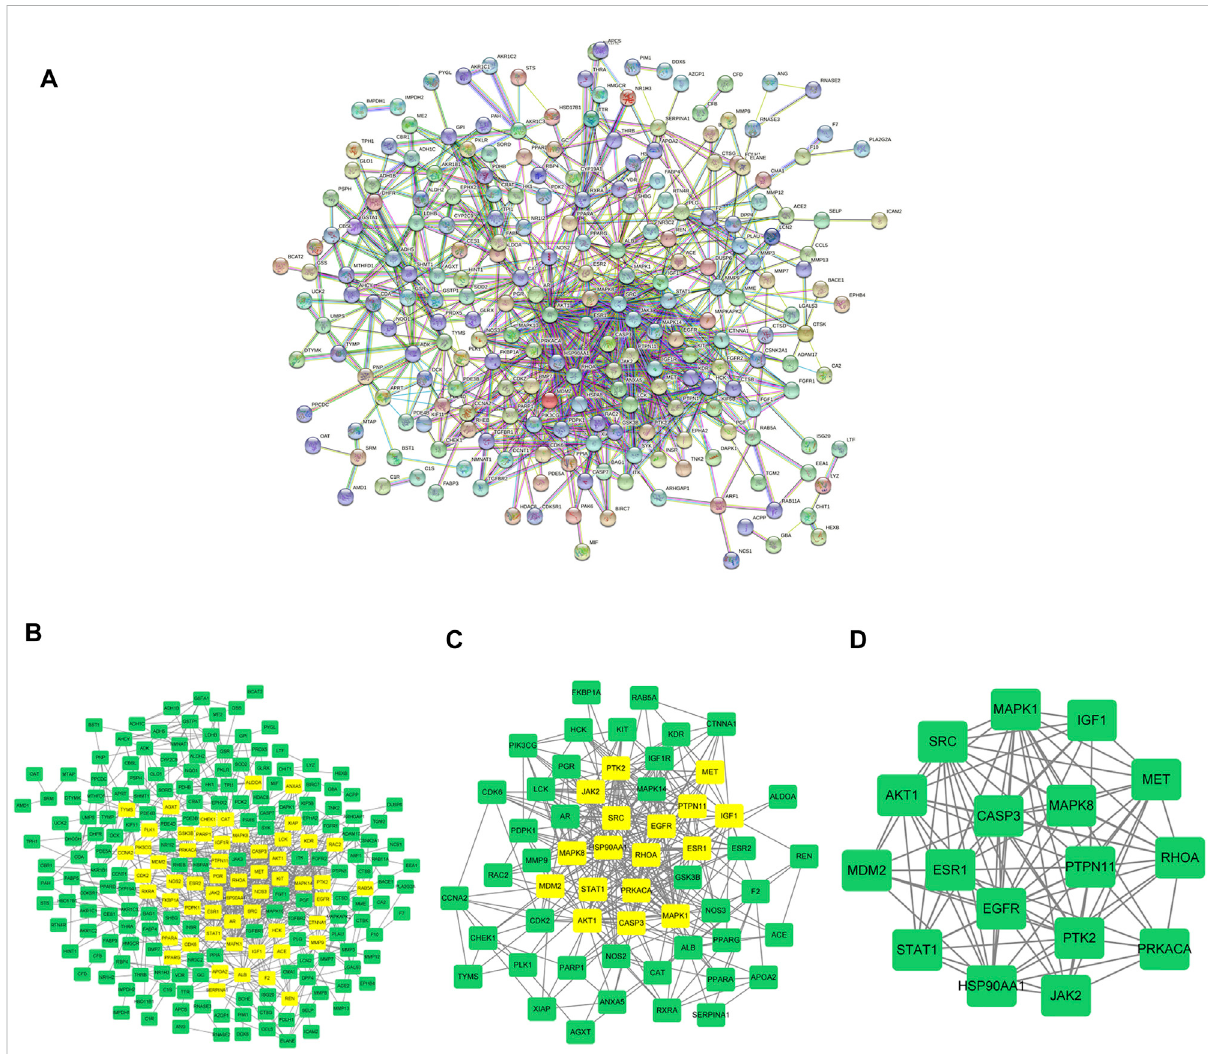
FIGURE 3 AnalysisonAML-RelatedPPI. (A) TheconstructionofproteininteractionnetworkofAMLtargetgenesinducedbyscutellarin. (B) Theinteractive PPI network of AML-related targets and scutellarin targets. (C) Further screening of AML target genes acted by scutellarin. (D) Seventeen core candidate target genes of scutellarin for AML